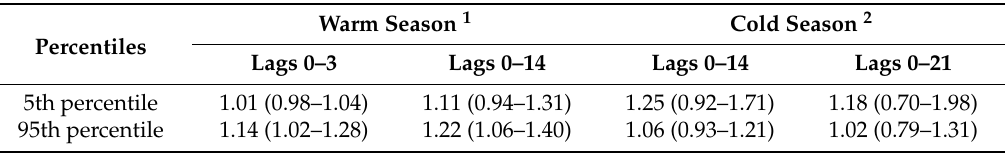
Table 1. Effects of temperature presented as relative risks along with 95% confidence intervals on psychiatric emergency visits (PEVs) relative to minimum effect temperature.